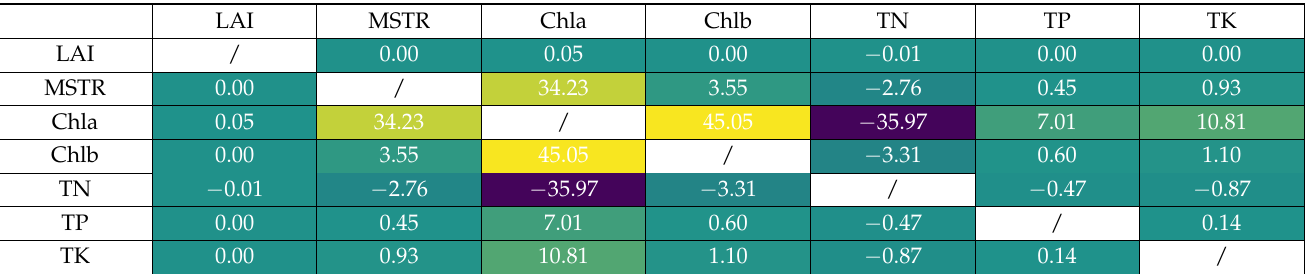
Table 5. Correlation matrix between nutrient contents and LAI. The correlation coefficient is a statistical measure used to assess the linear relationship between two variables and reflects whether the two variables change in the same direction. The correlation coefficient ranges from − 1 to 1, with larger absolute values indicating a stronger relationship between the two variables.